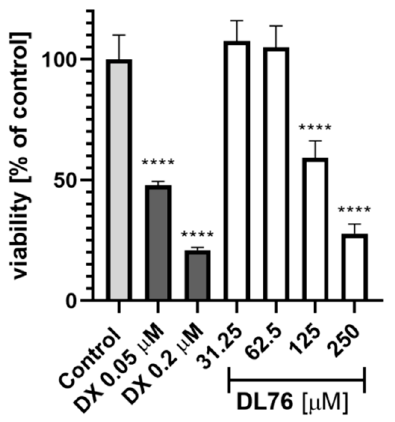
Figure 5. The effect of DL76 and doxorubicin (DX) on HEK-293 viability: Statistical significance (**** p < 0.0001) was analyzed by GraphPadPrism™ 8 software using one-way ANOVA and Bonferroni’s multiple comparison posttest in comparison with control (1% DMSO in cell culture medium).